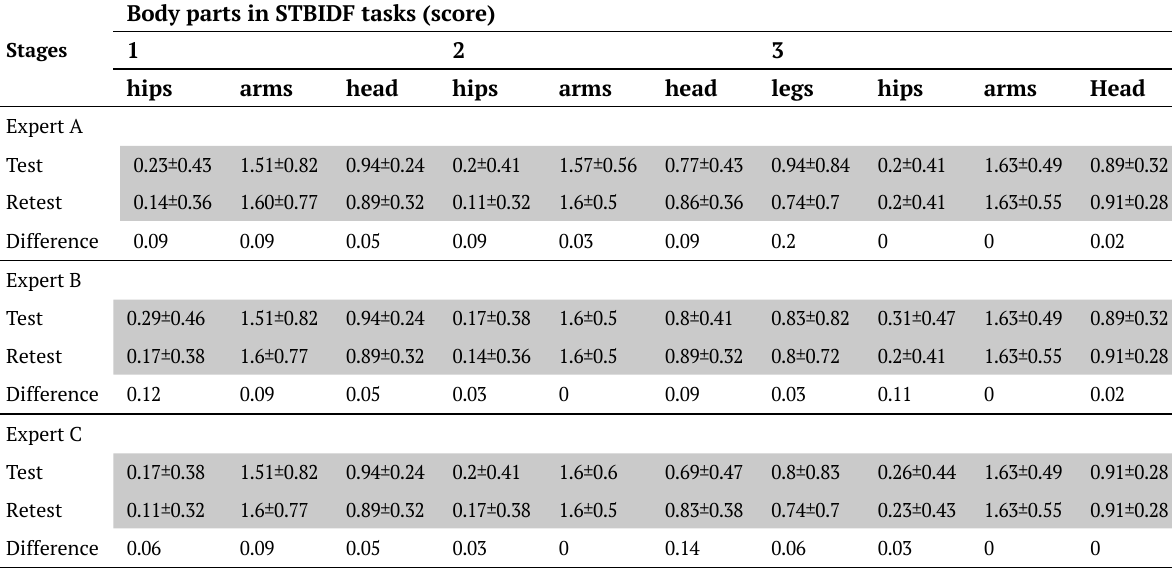
Table 4. Mean score and standard deviation corresponding to susceptibility of the predetermined parts of the body to injuries in physiotherapy students (n =